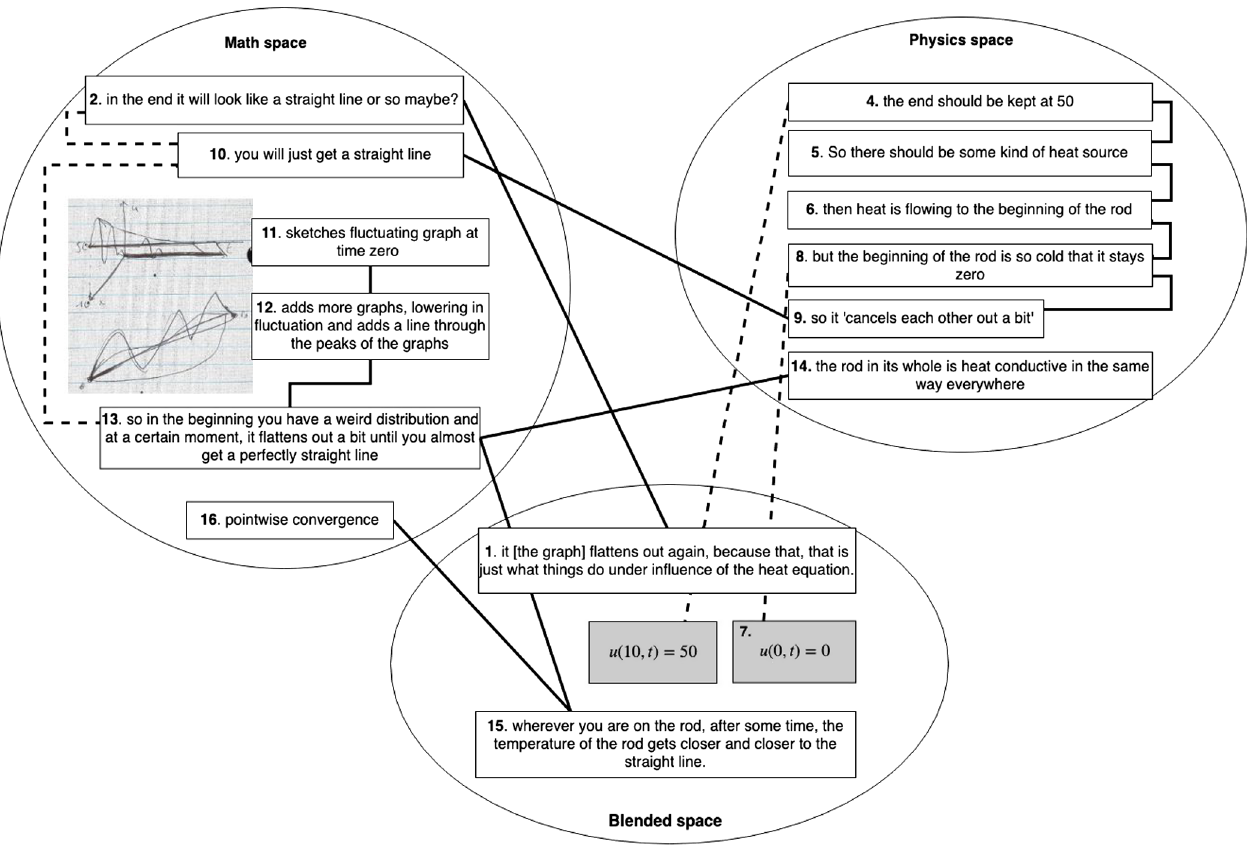
FIG. 10. DBD 2: David and Evan ’ s answer to question